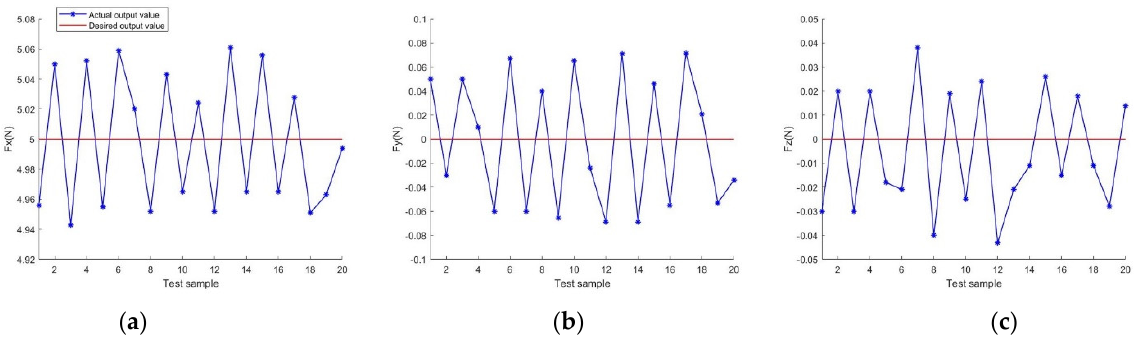
Figure 10. Output values of each channel when 5N load is applied in Fx direction. ( a ) Fx channel output value; ( b ) Fy channel output value; ( c ) Fz channel output value.